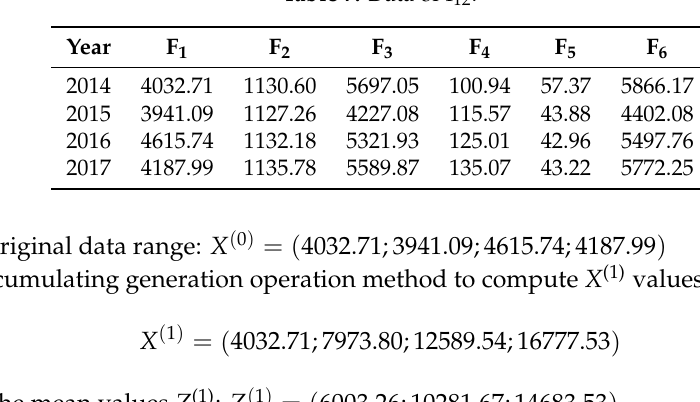
Table 7. Data of I 12